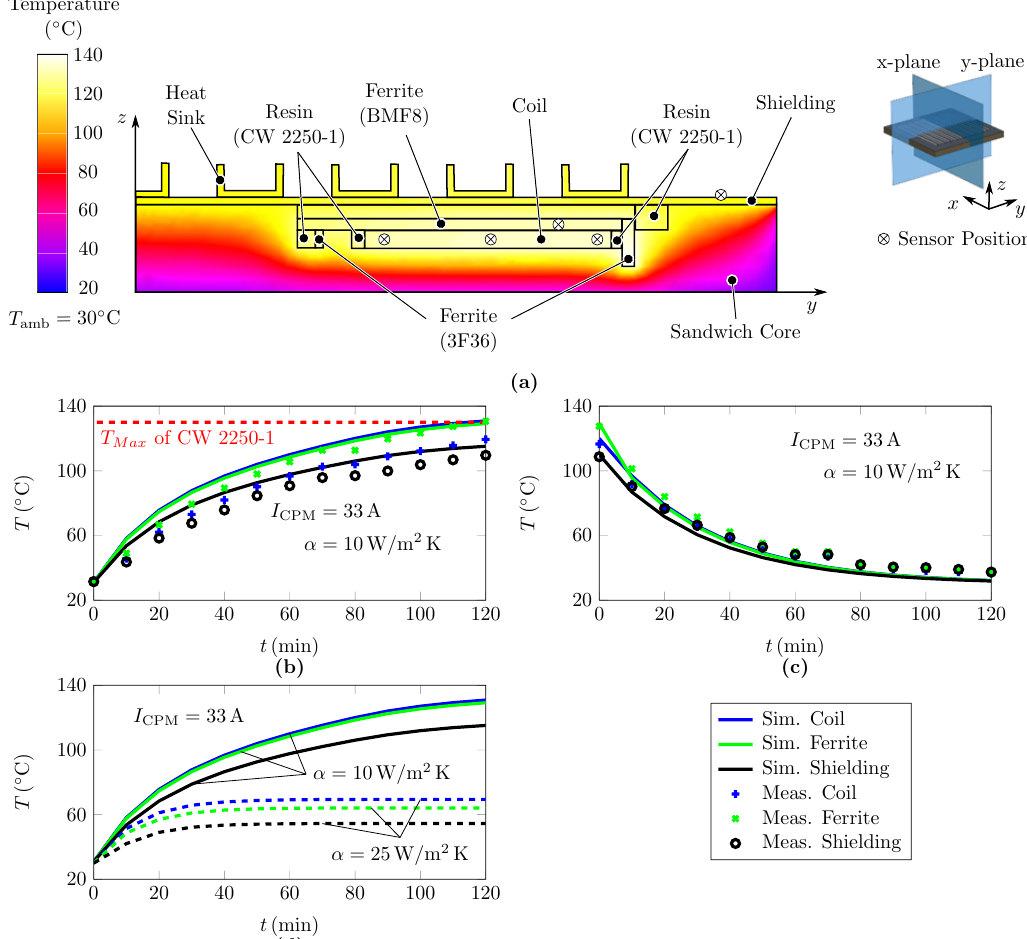
Figure 12. ( a ) Results of the thermal FE analysis of sandwich concept on component level at t = 120min, ( b ) comparision of heating results of FE analysis and component level testing with natural convection, ( c ) comparision of cool-down results of FE simulation and component level testing with natural convection and ( d ) comparision of FE analysis with natural ( α = 10W/m 2 K) and forced convection ( α = 25W/m 2